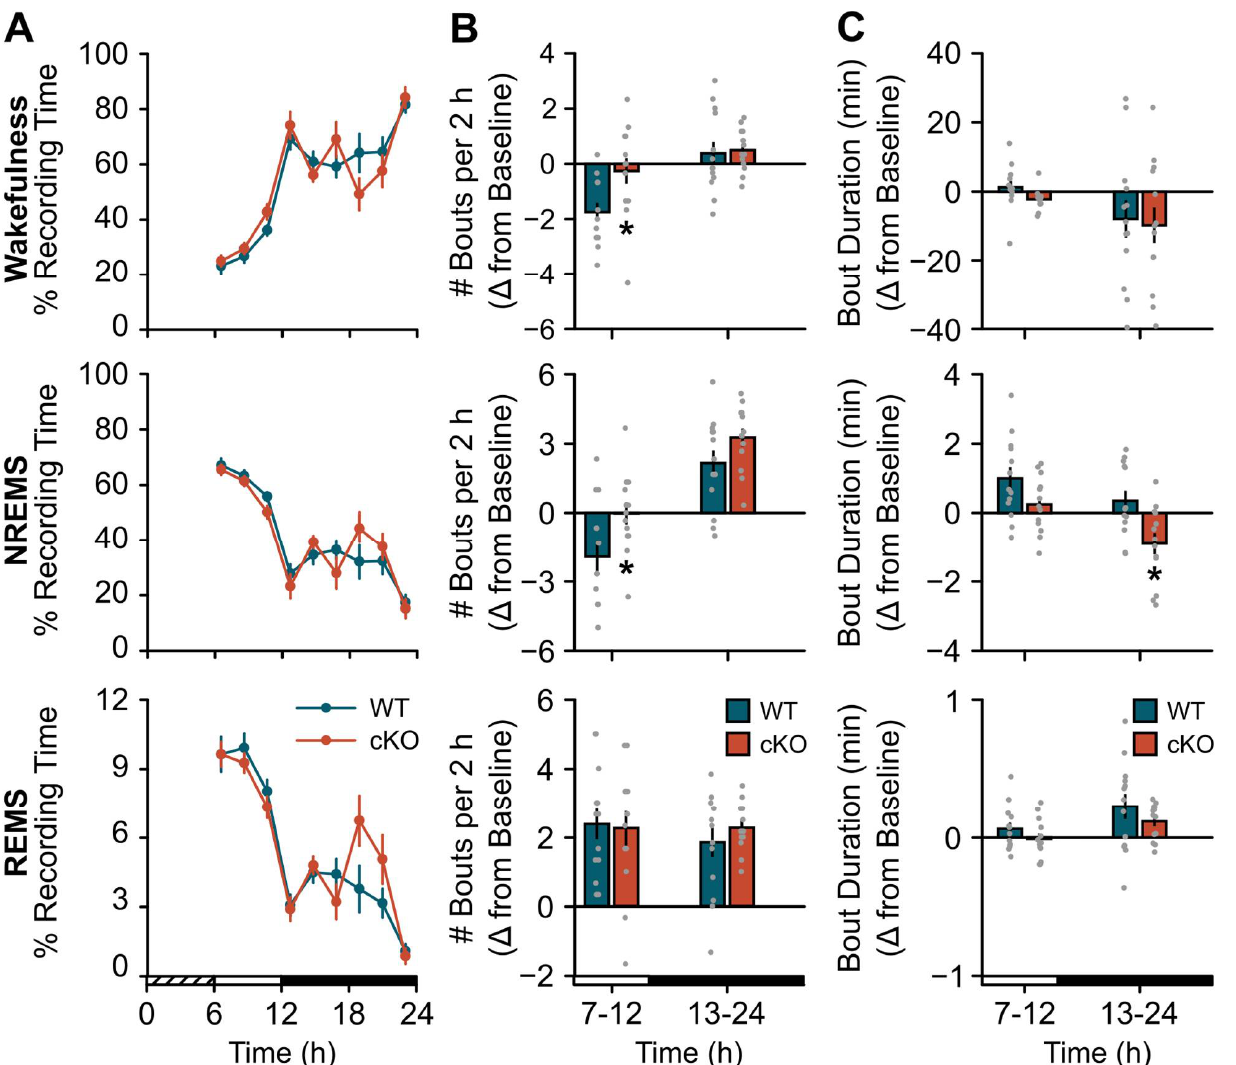
Figure 2. Conditional deletion of astroglial β2-ARs blunts the compensatory response to sleep deprivation (SDep): sleep consolidation. ( A ) Time spent in wakefulness (top), NREMS (middle), and REMS (bottom) after 6 h SDep expressed as a percentage of total recording time in 2 h bins. ( B ) Average bout frequency and ( C ) bout duration shown as change from baseline (SDep–baseline differences) during 6 h (light period) and 12 h (dark period) bins post-SDep recovery for wakefulness (top), NREMS (middle), and REMS (bottom). Cross-hatched bars on the x -axis denote the 6 h SDep period. Open and closed bars on the x -axis denote the recovery phase light and dark periods, respectively. Values are means ± SE from n = 13 WT and n = 13 cKO mice. * p < 0.05 (repeated measures ANOVA).